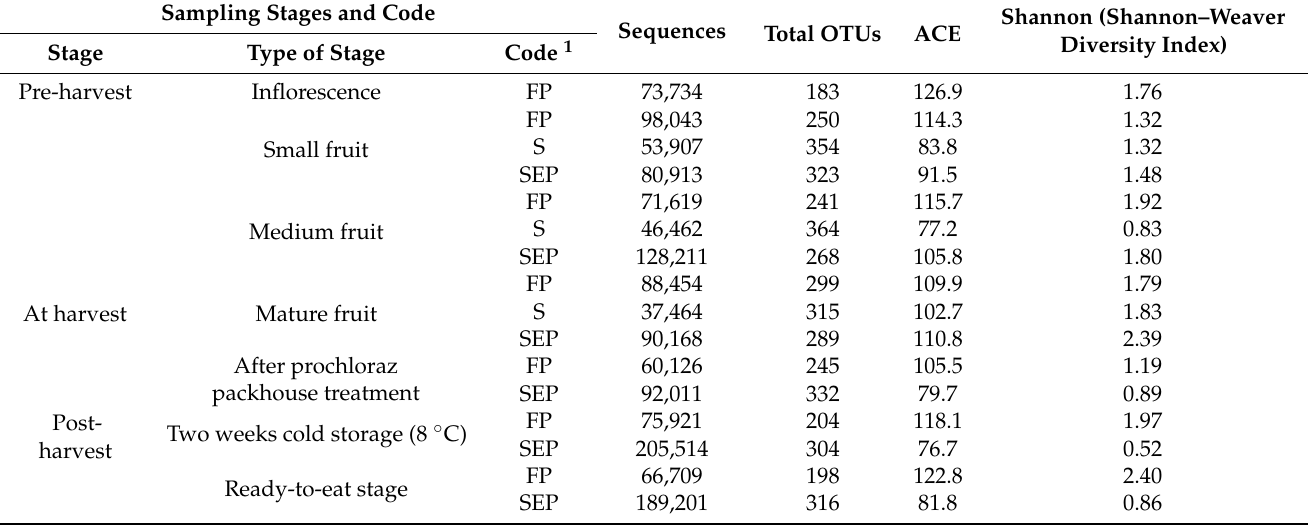
Table 3. Summary of fungal amplicon sequence counts and diversity estimators for mango inflorescence, fructoplane, fruit stem and stem-end pulp at the pre- and post-harvest stages of cv. Tommy Atkins